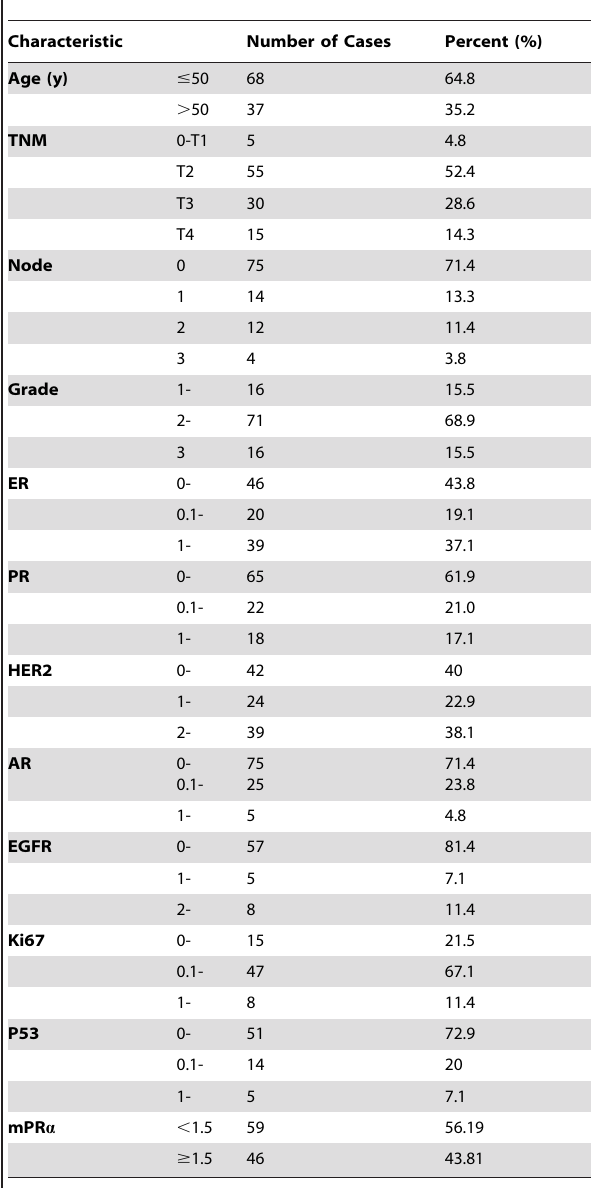
Table 1. Clinicopathologic characteristics